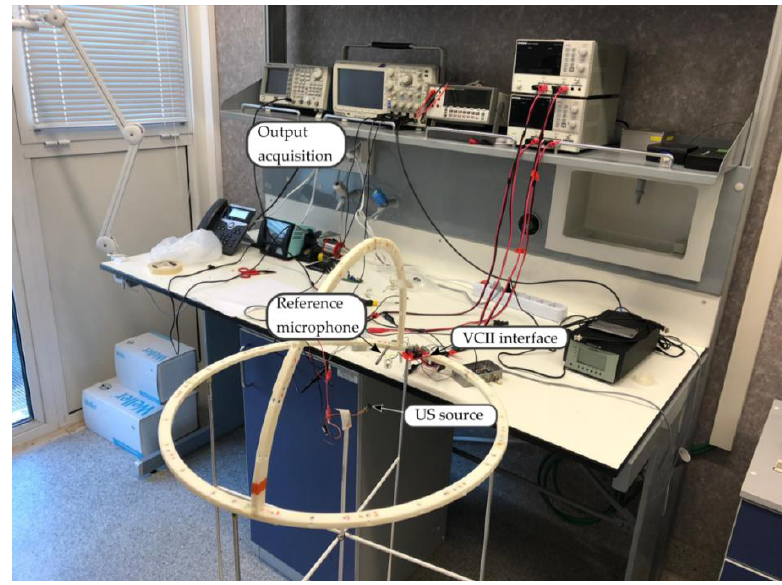
Figure 6. Measurement setup.